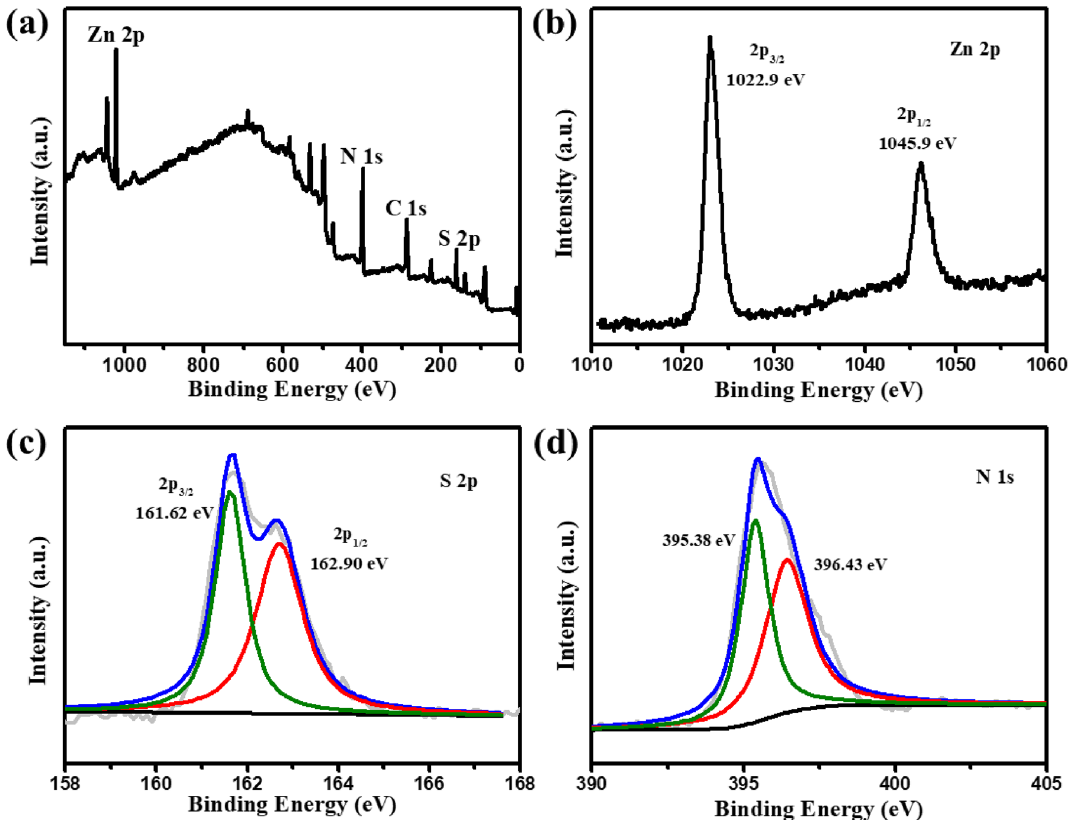
Fig. 3 XPS spectra of the N@ZnS/Zn samples: a Full spectrum; b Zn 2 p spectrum; c S 2 p spectrum; d N 1 s